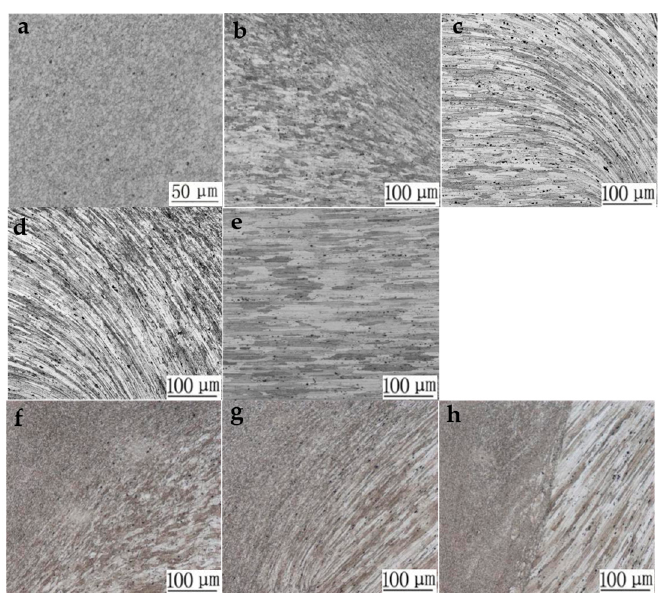
Figure 6. Microstructure in different regions of the joint welded by optimal condition: ( a ) plug zone (PM), ( b ) friction interface zone (FIZ), ( c ) thermo-mechanically affected zone (TMAZ), ( d ) heat affected zone (HAZ), ( e ) base material (BM), ( f – h ) bonding interface.